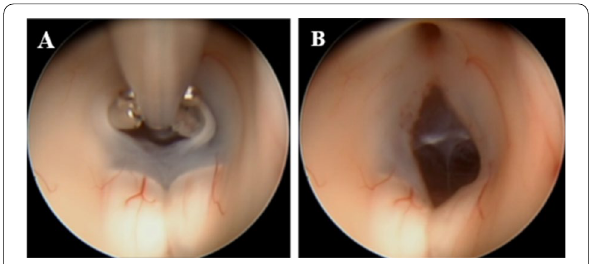
Fig. 3 A : Techniques of widening the stoma, B : the stoma after being widened by grasping